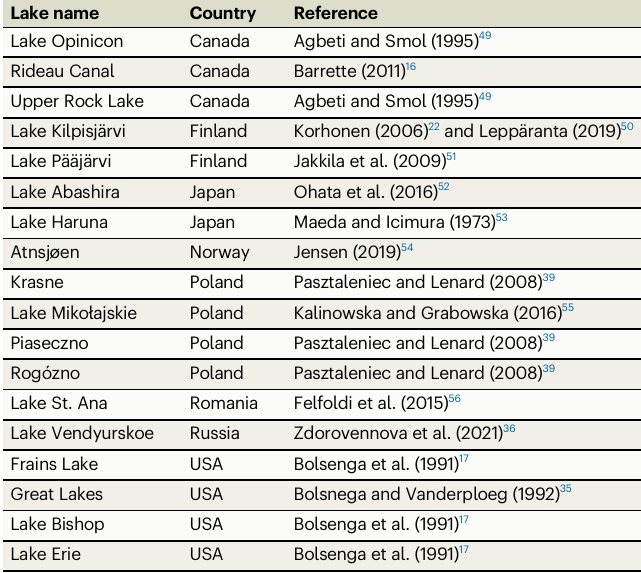
Table 1 | Examples of lakes for which some ice quality data were available in the literature (for location of the lakes see Fig.